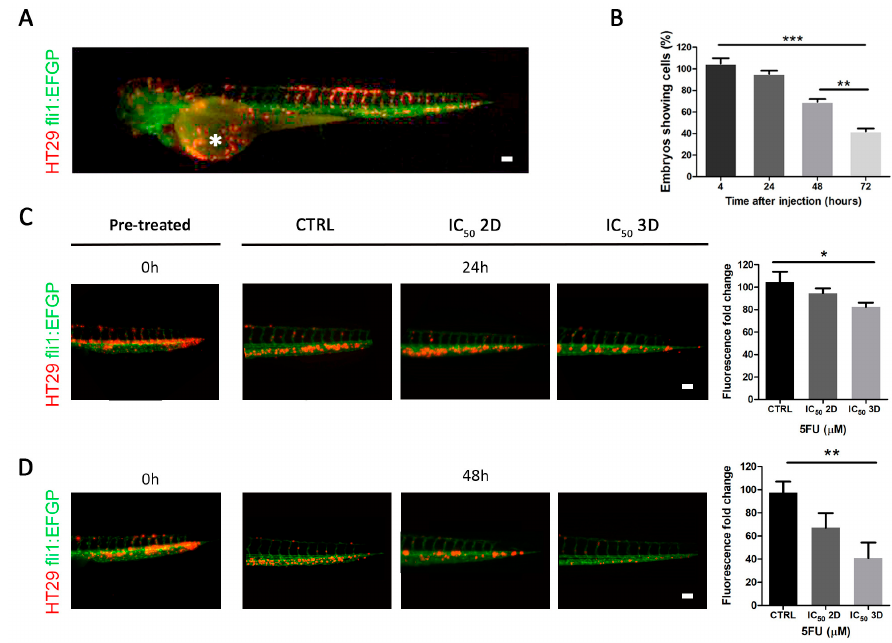
Figure 3. Effect of 5FU treatment on in vivo zebrafish model. ( A ) Tg(fli1:EGFP) zebrafish embryo (with green fluorescent vessels) xenotransplantated with Dil marked HT29 cells (red), injected into the duct of Cuvier (white asterisk). ( B ) The monitoring of zebrafish embryos showed viable cells after 24-48-72 h post-injection. ( C ) Analysis of Dil + HT29 injected cells in zebrafish embryos, pre-treatment (time 0), after 24 h of treatment with DMSO (control group), IC 50 2D, IC 50 3D, and relative quantifications (scale bar = 100µm). ( D ) Analysis of Dil + HT29 injected cells in zebrafish embryos, pre- treatment (time 0), after 48 h of treatment with DMSO (control group), IC 50 2D, IC 50 3D, and relative quantifications (scale bar = 100µm) (* p -value < 0.05; ** p -value < 0.01; *** p -value <